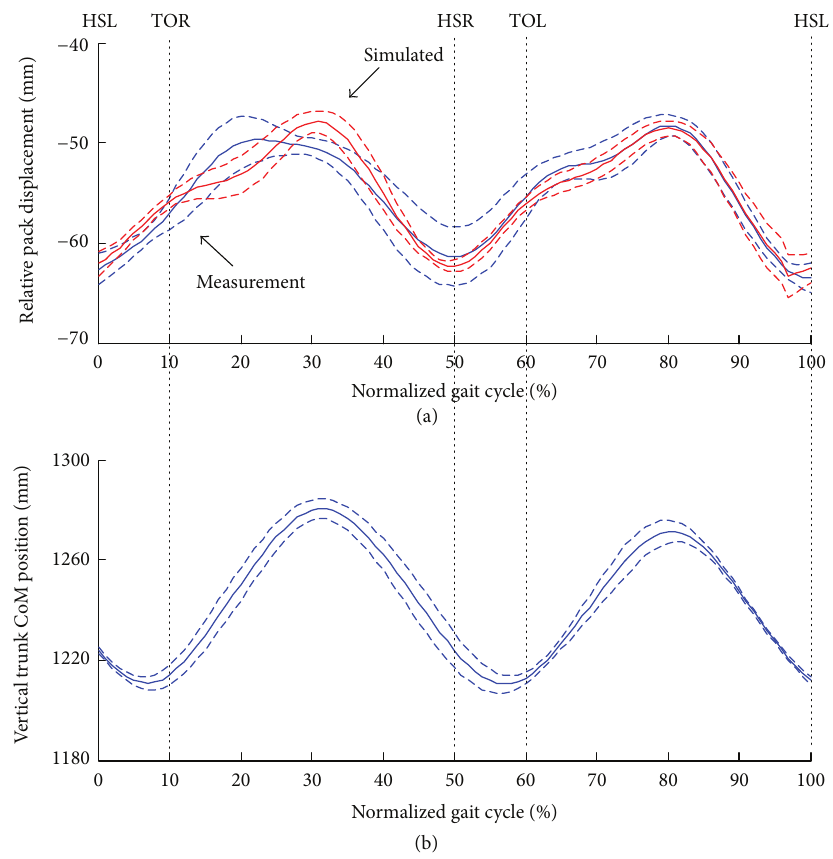
Figure 10: The simulated relative pack displacement along the back (mean (solid red line) ± one standard deviation (dashed red lines), (a)), compared with measured data (mean (solid blue line) ± one standard deviation (dashed blue lines), (a)), for six repeated trials for one subject (age: 28 yrs, weight: 71.8 kg, height: 178cm), and measured vertical trunk CoM displacement (mean (solid blue line) ± one standard deviation (dashed blue lines), (b)). The average walking speed was 1.62 ± 0.04 m/s, and the pack load was 23.0 kg. The stance phase for the left limb is from 0 to 60.3%, and the swing phase is from 60.3% to 100%. The double support phase is from 0 to 10.3% and from 50 to